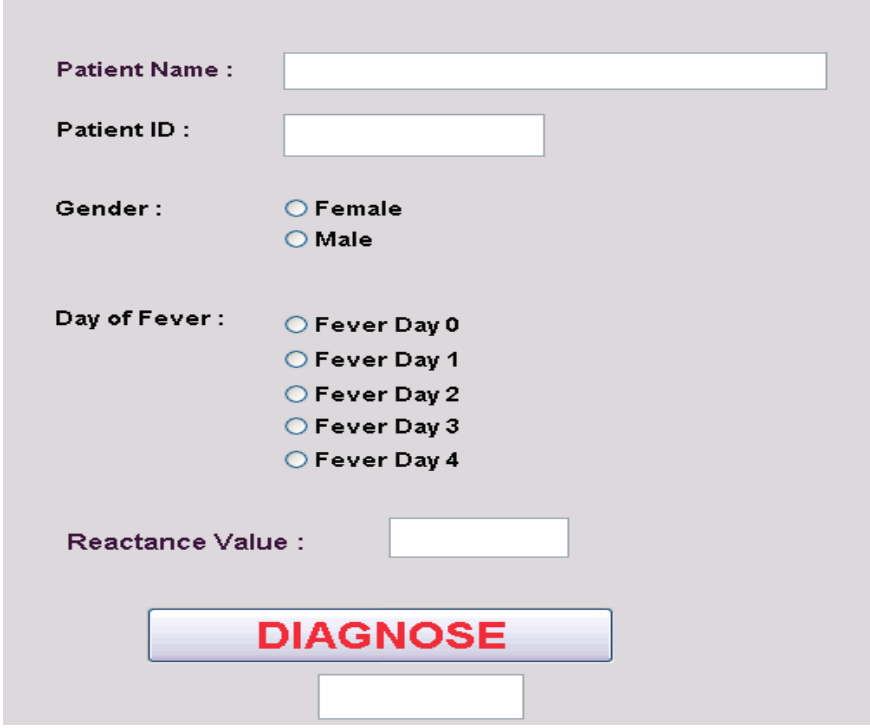
Figure 4. An Automatic dengue risk diagnostic system using artificial neural networks and bioelectric impedance analysis